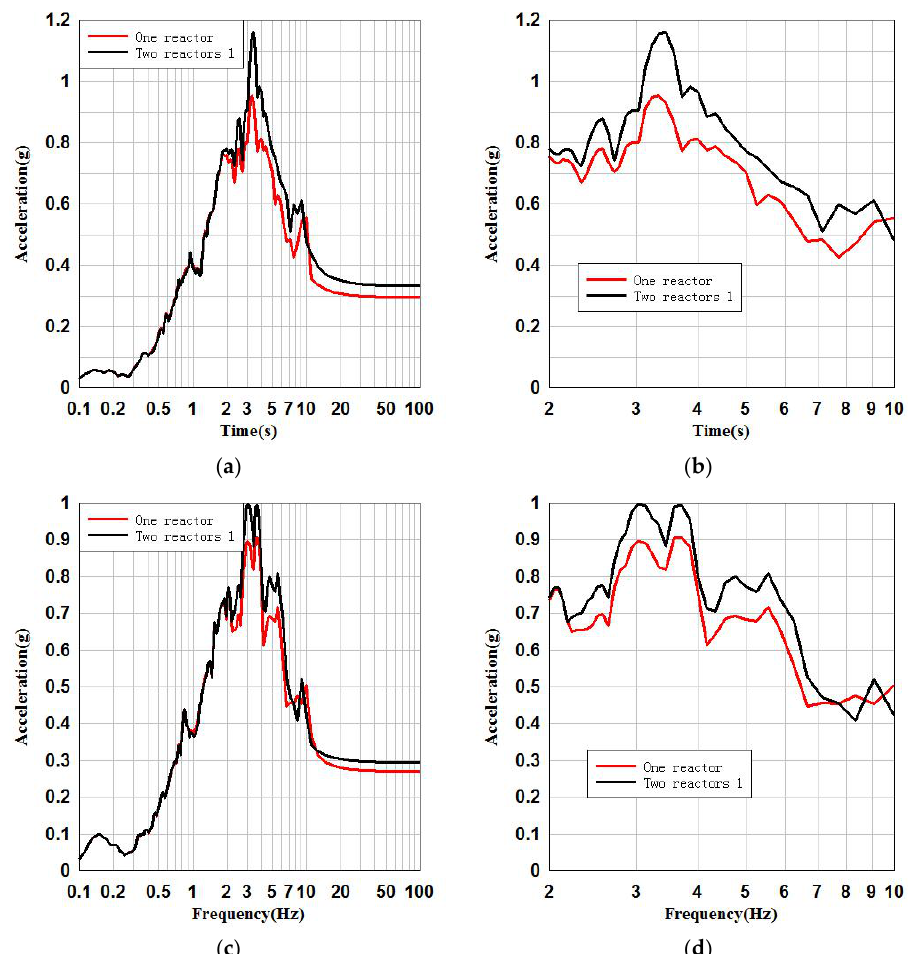
Figure 10. FRS of key floor reference points of SSI system and SSSI system in x and y directions. ( a ) FRS of the key floor in the x direction. ( b ) Floor response spectrum of the key floor in the x direction (2–10 Hz). ( c ) FRS of the key floor in the y direction. ( d ) FRS of the key floor in the y direction (2–10 Hz). Table 13. Relative changes of x and y peak accelerations of reference points on key floors of SSI system and SSSI system.